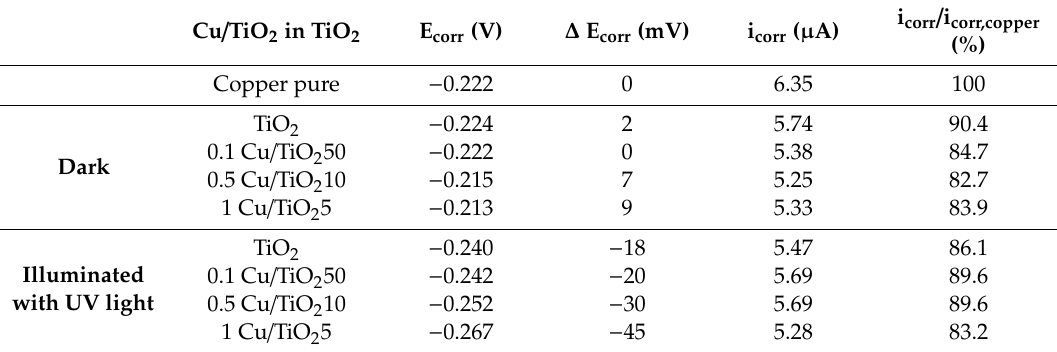
Table 2. E corr and i corr of terminal lug coated with nanocomposite